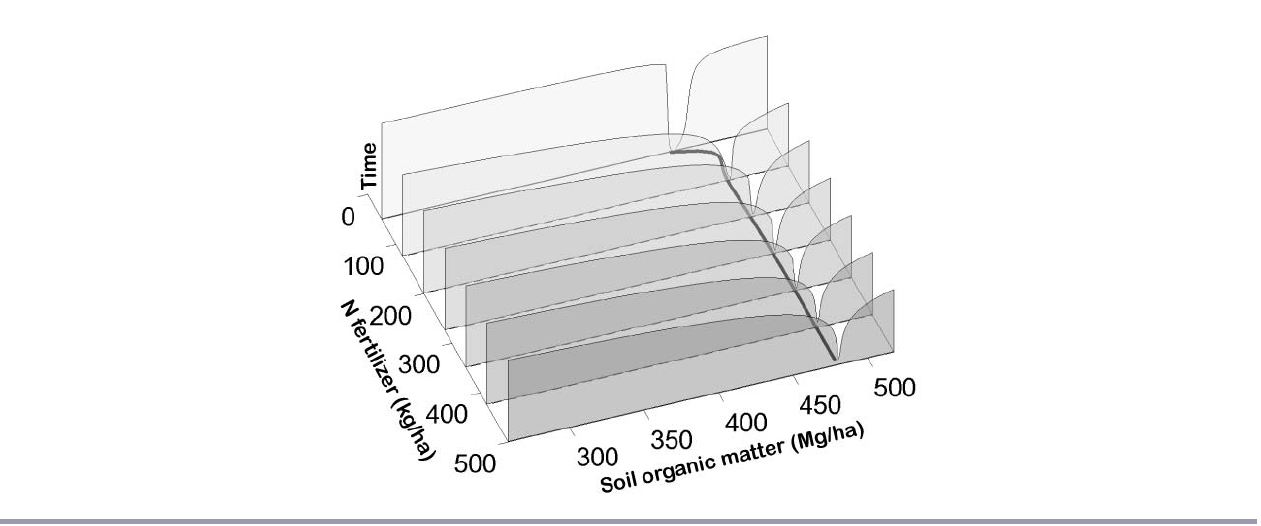
Fig. 3. Stability landscape of the interaction between fertilizer input and soil organic matter. For a broad range of soil organic matter values the time of reaching equilibrium conditions with a certain N-fertilizer application is calculated. This period of time needed to reach equilibrium is represented by height of the landscape. Initial condition is a field after maize cultivation and based on Sonneveld et al.